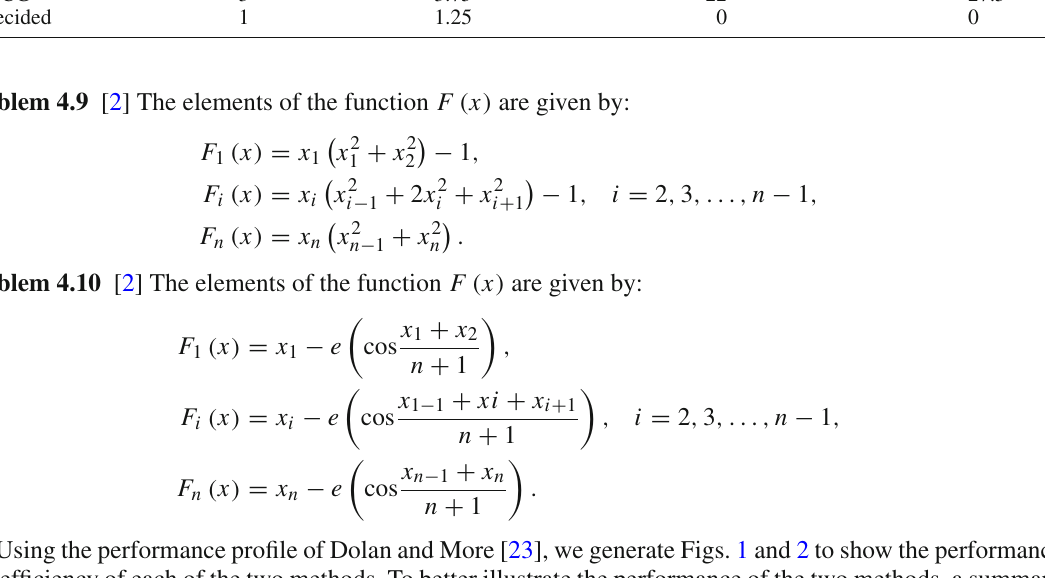
Table 2 Number of problems and percentage for which each method is a winner with respect to iterations and CPU time Method Iter Percentage CPU time Percentage ADLCG 76 95 58 72.5